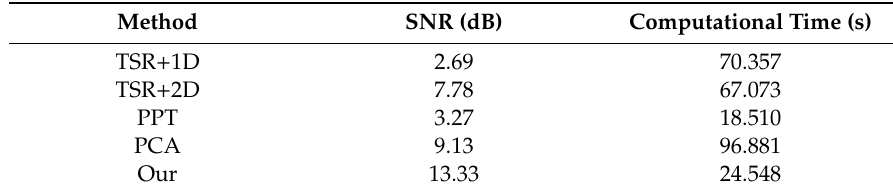
Table 2. Comparison of the Signal-to-Noise Ratio (SNR) and the Computational Time for the Proposed and Existing Methods.